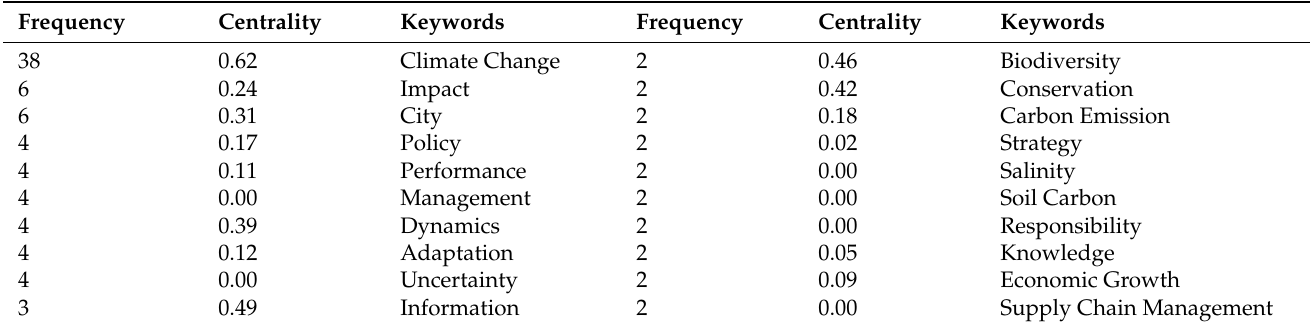
Table 1. Keywords and their detailed